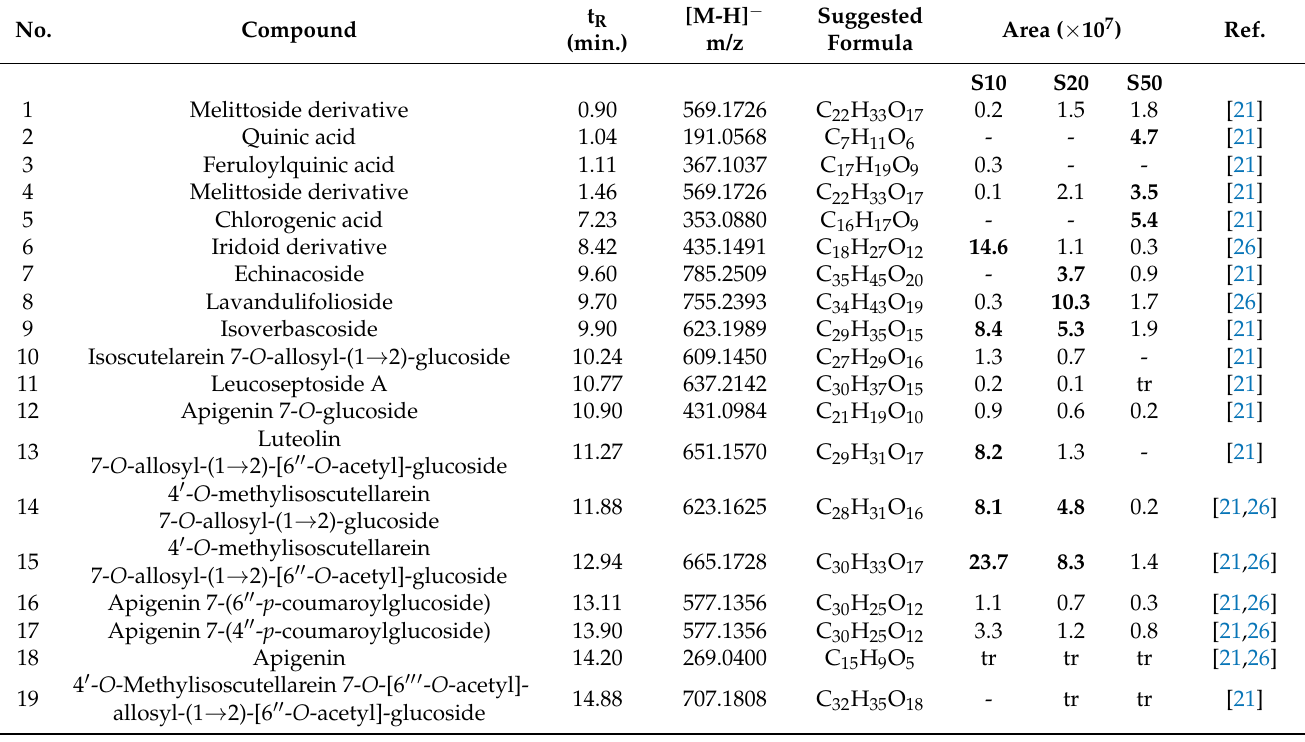
Table 2. Chemical components of S10, S20, and S50 fractions from the methanol total extract of wild S. sipylea identified by UPLC-ESI